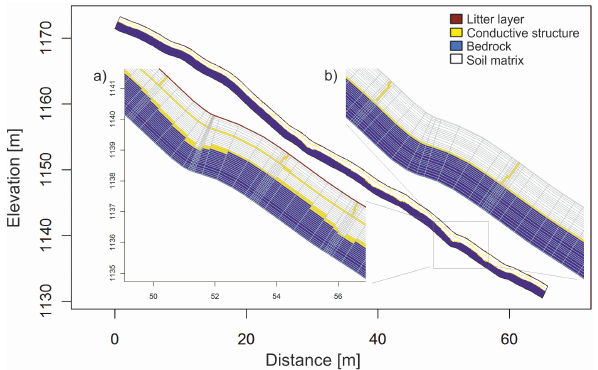
Fig. 2. Set-up of hillslope model in profile view; the insets show en- larged detail with different realisations of explicit structures: (a) set- up with litter layer, vertical flow paths (2m spacing), lateral flow path, and soil–bedrock interface layer on interpolated bedrock to- pography; (b) set-up with widely spaced vertical flow paths (4m spacing) and soil–bedrock interface layer at constant soil depth over the entire profile; the inset is at the same scale as (a)